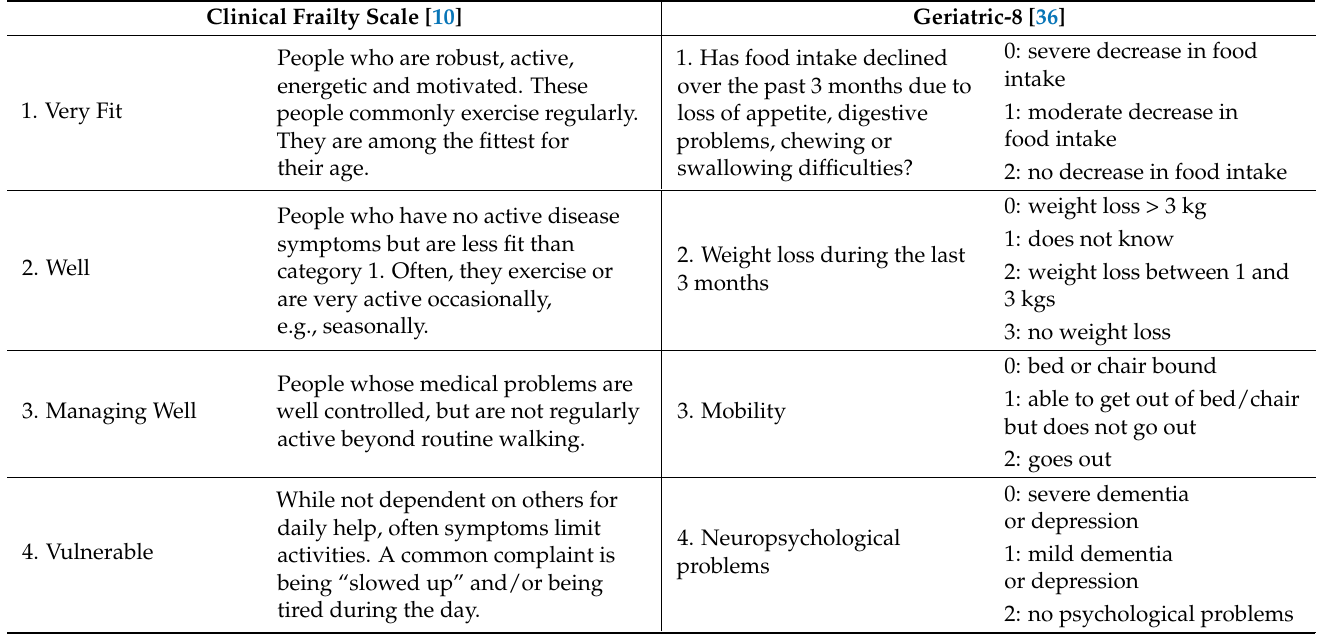
Table 1. An overview of two commonly used frailty screening methods: the Clinical Frailty Scale and the